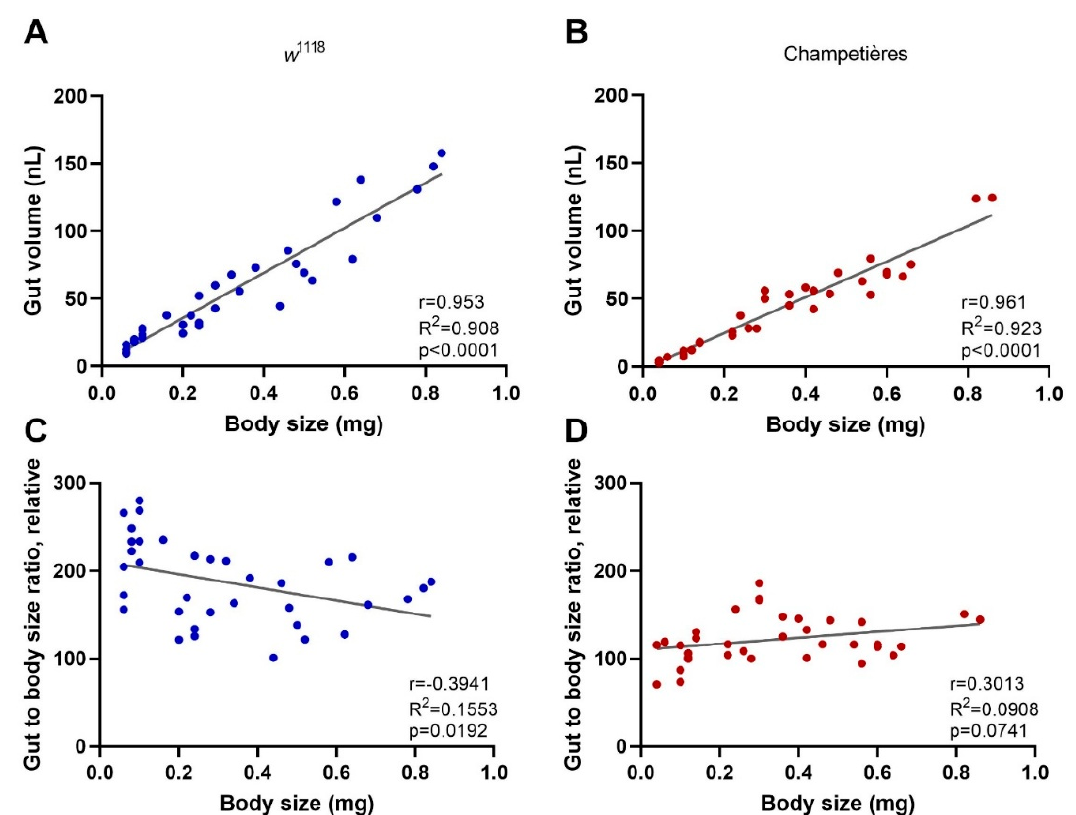
Figure 2. The size of the gut increases in a proportional manner to the total body size: larvae of the w 1118 (blue circles: ( A , C )) and Champetières (red circles: ( B , D )), fly lines of different sizes and instars (L1, L2, and L3) were simultaneously selected and fed with standard solutions of FITC-dextran particles. Groups of 5 similarly sized larvae were weighed, surface cleaned, and macerated, to measure the ingested FITC content and estimate the volume of the gut. The correlation between average weight and average gut volume per group of 5 larvae was estimated using a Pearson correlation test ( A , B ), indicating a positive strong correlation between total body and gut size as the larvae grow. Furthermore, the gut-to-body ratio was calculated, and a Pearson test was used to evaluate its correlation to body size ( C , D ), indicating no correlation for Champetières, and a weak negative correlation for w 1118 larvae.